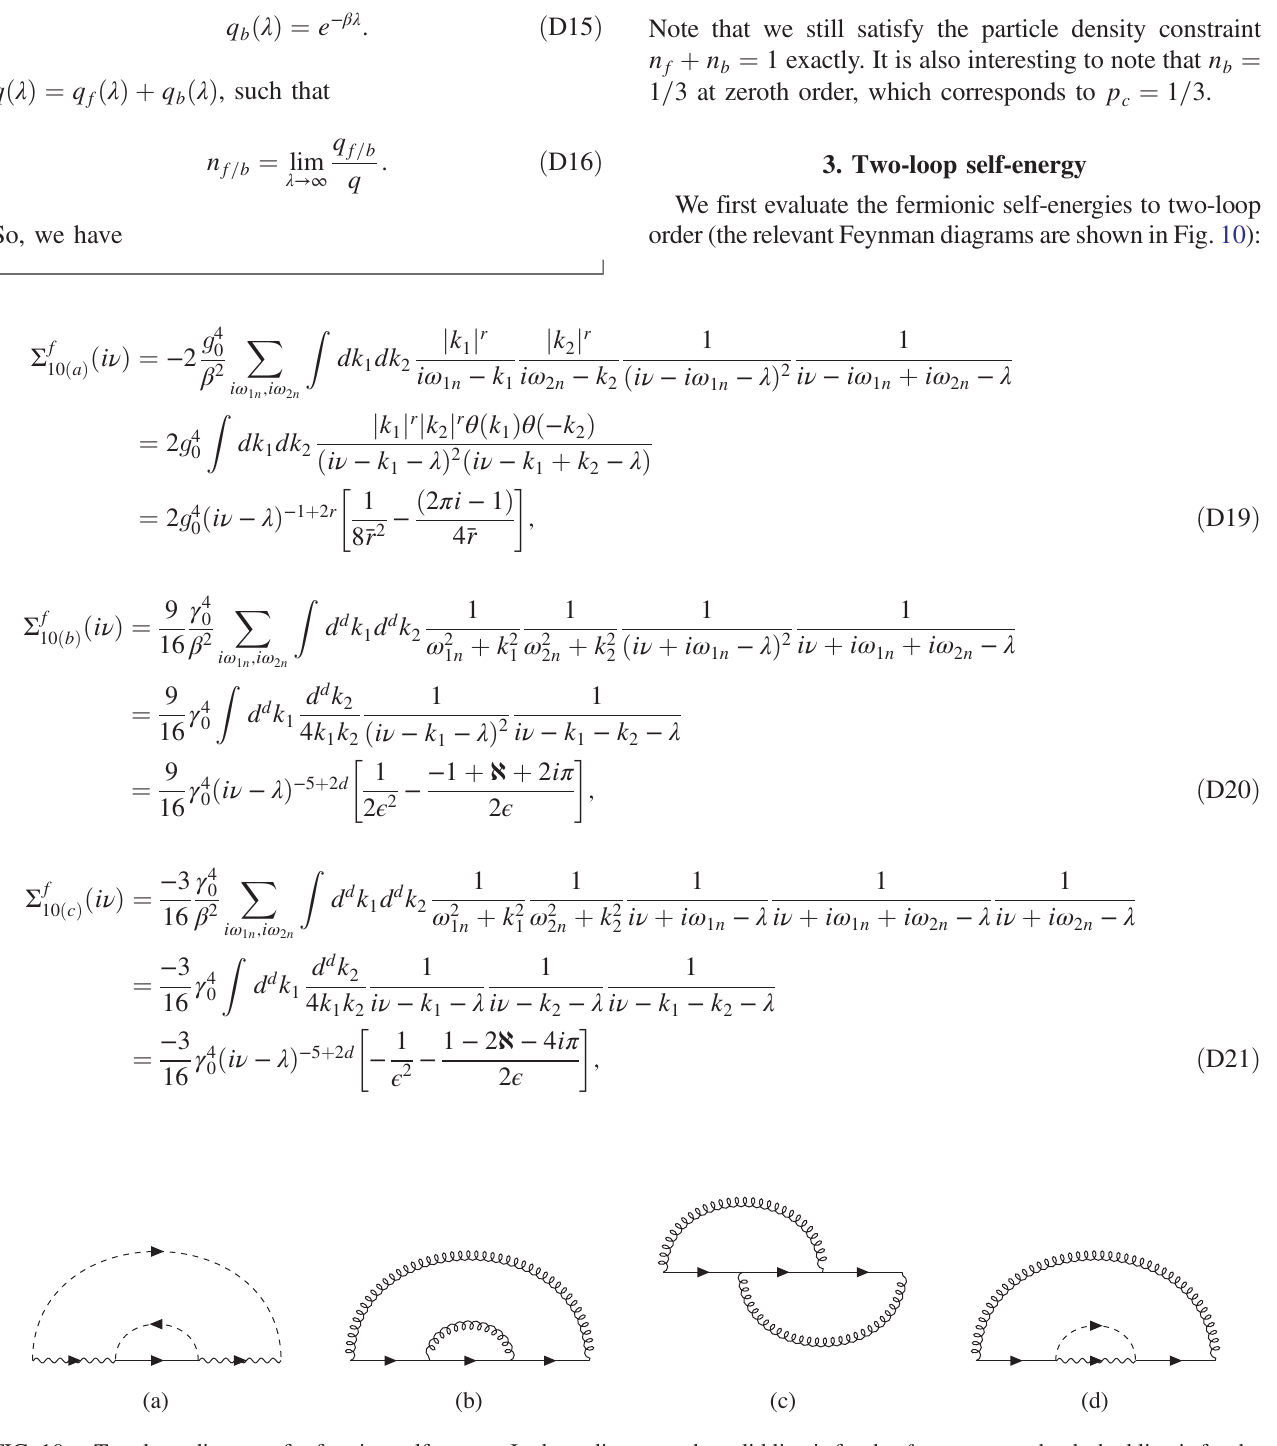
FIG. 10. Two-loop diagrams for fermion self-energy. In these diagrams, the solid line is for the f propagator, the dashed line is for the ψ propagator, the wavy line is for the b propagator, and the spiral is for the ϕ